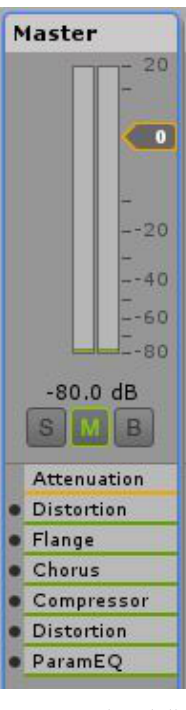
Figure 6. Virtual